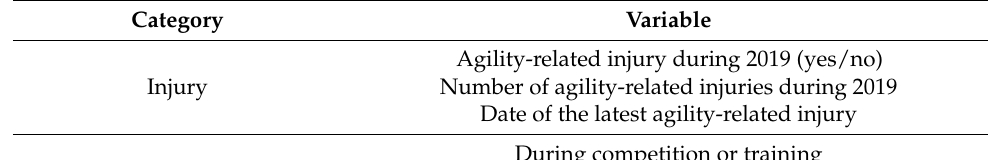
Table 1. Injury-related variables provided by the